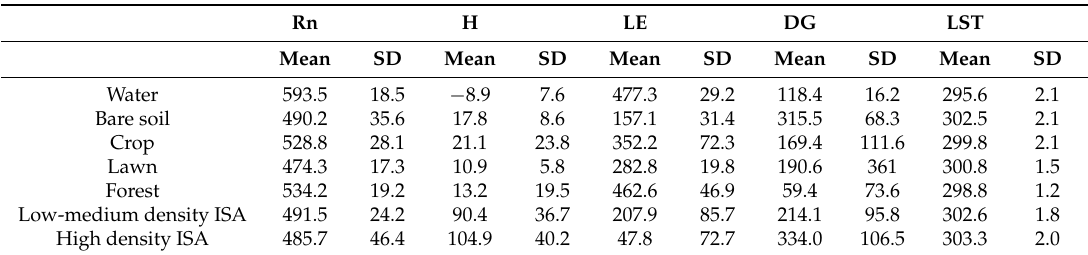
Table 4. Descriptive statistics for heat fluxes over different